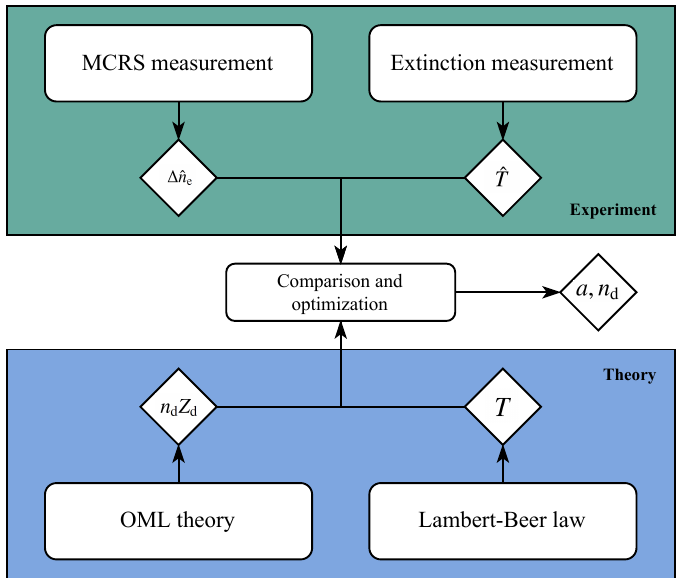
Figure 2. Flowchart for the retrieval of the best fitting dust particle size and dust density from the comparison of experimental MCRS and extinction measurements and the OML theory and the Lambert-Beer